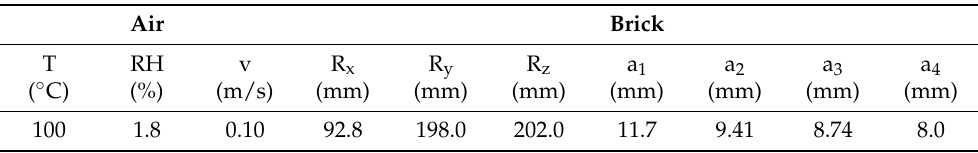
Table 3. Experimental parameters of air and dimensions of hollow ceramic bricks used in the experiments [8].